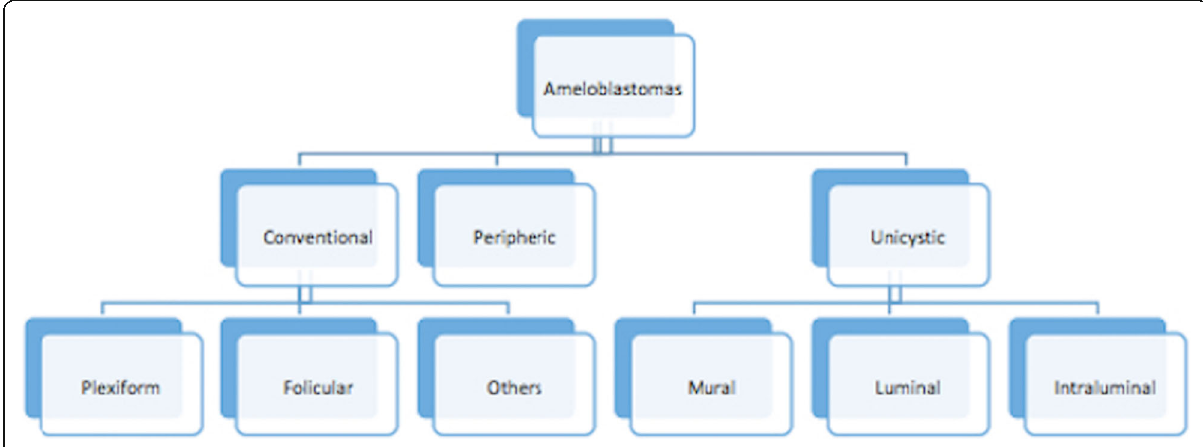
Fig. 1 Flowchart with the new classification of ameloblastomas -